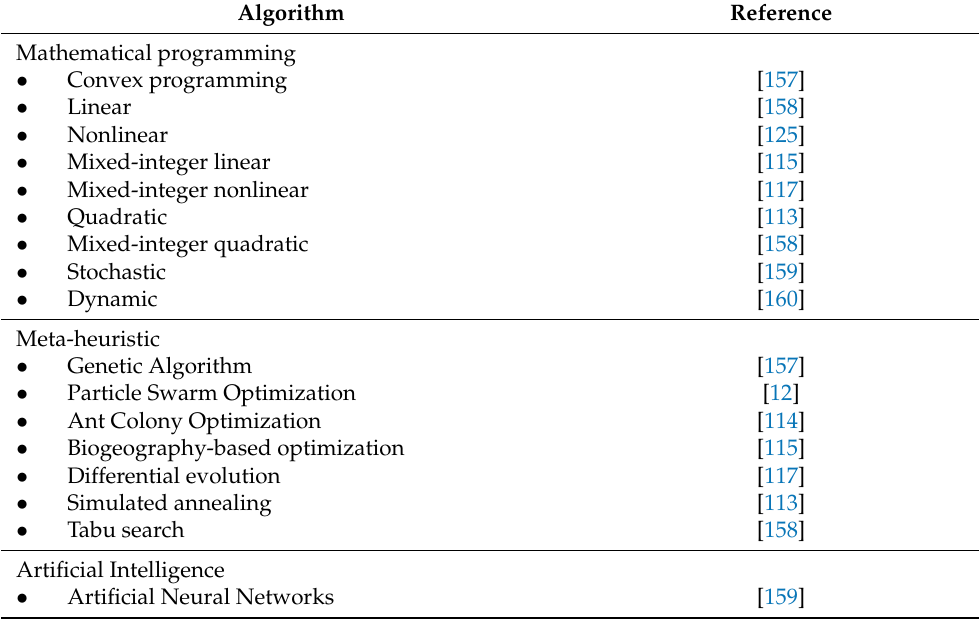
Table 9. Most common optimization